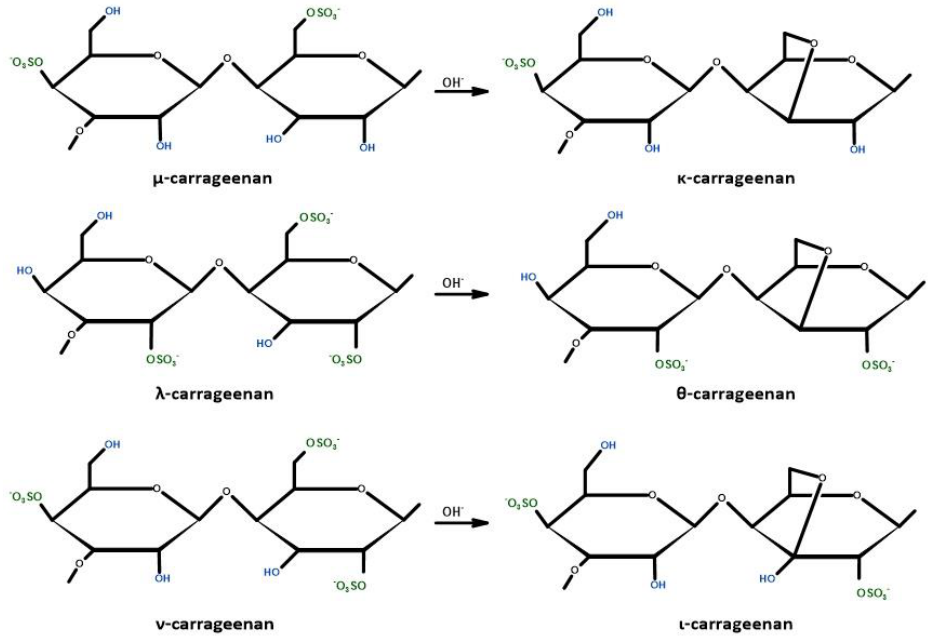
Figure 6. Chemical structure of commercial carrageenans.